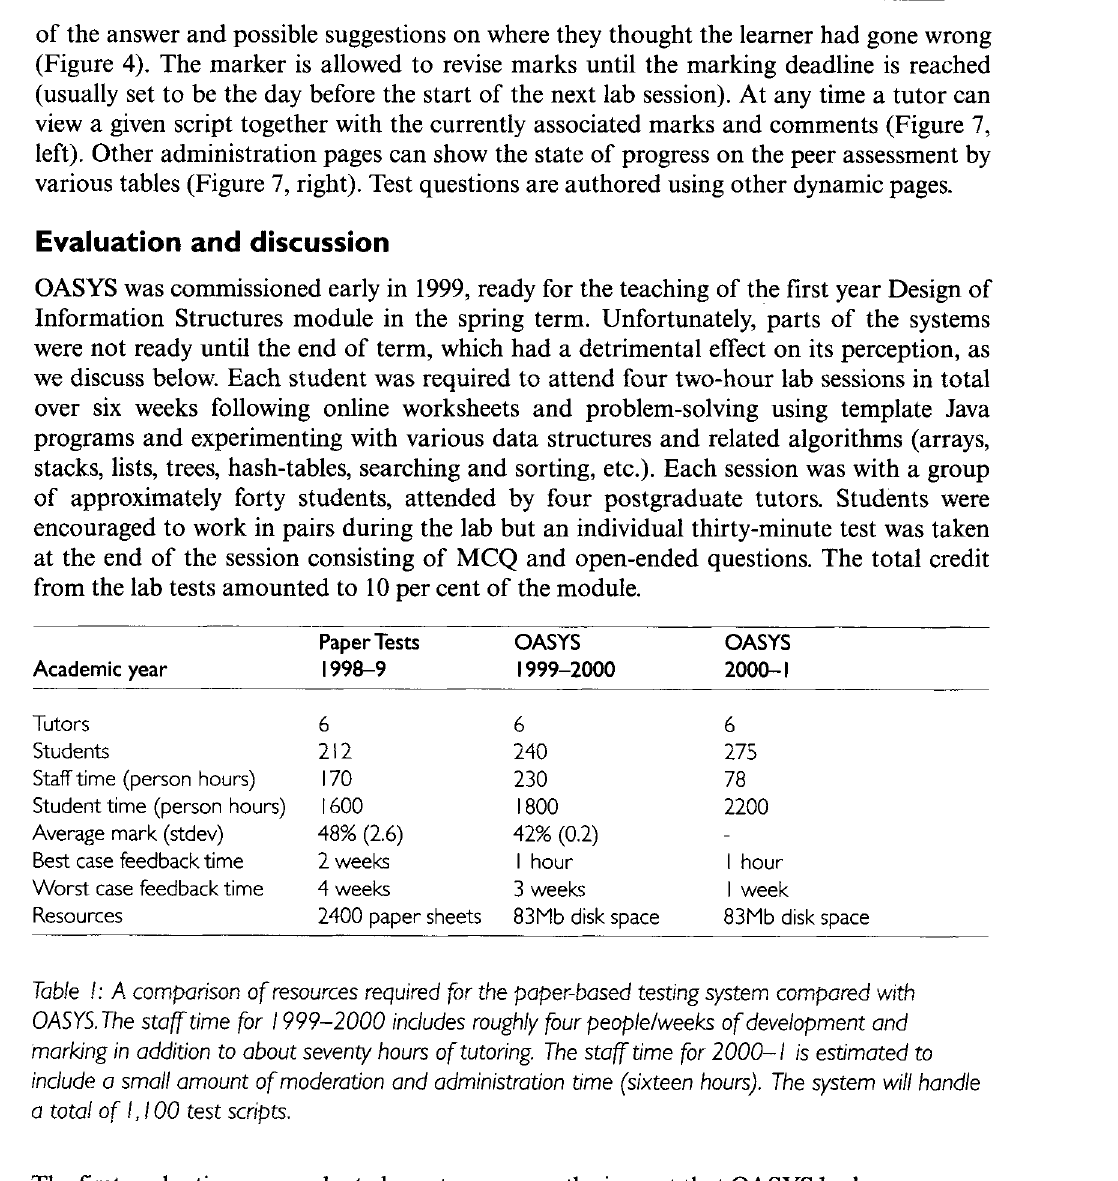
Table t: A comparison of resources required for the paper-based testing system compared with OASYS. The staff time for 1999-2000 includes roughly four people~weeks of development and marking in addition to about seventy hours of tutoring. The staff time for 2000-1 is estimated to indude a small amount of moderation and administration time (sixteen hours). The system will handle a total of I, I O0 test